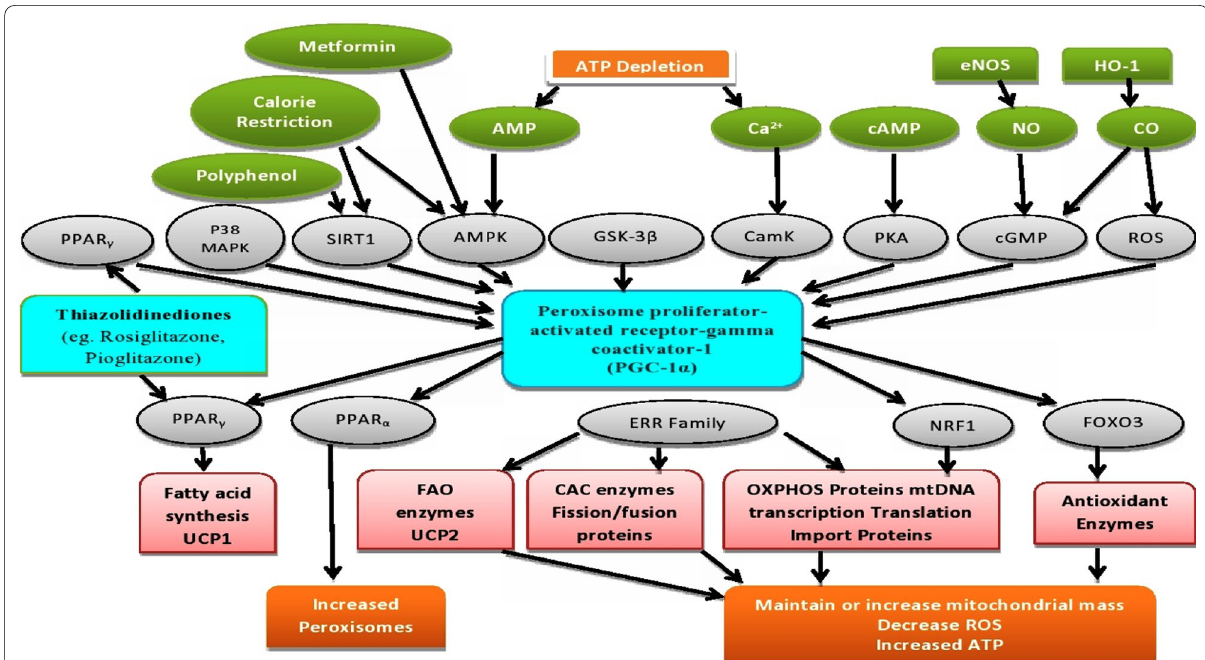
Fig. 7 Different mitochondrial biogenesis promoting genes and their promoting pathways. AMP: Adenosine monophosphate; Ca 2 + : Calcium (2 ); cAMP: Cyclic adenosine onophosphate; NO: Nitric Oxide; CO: Carbon Monoxide; PPAR: Peroxisome proliferator-activated receptors; MAPK: + Mitogen-activated protein kinases; SIRT1: sirtuin (silent mating type information regulation 2 homolog) 1; AMPK: AMP-activated protein kinase; GSK-3β: Glycogen synthase kinase 3 beta; camK: Ca 2 + /calmodulin-dependent protein kinase; PKA: protein Kinase; cGMP: Cyclic Guanosine Monophosphate; ROS: Reactive Oxygen Species ; ERR: Estrogen-related receptor; NRF 1: Nuclear Respiratory Factor 1; FOXO3:Forkhead box O3; UCP: Uncoupling Protein; CAC: Coronary Artery Calcification; OXPHOS: Oxidative Phosphorylation; mtDNA: Mitochondrial DNA; ATP: Adenosine